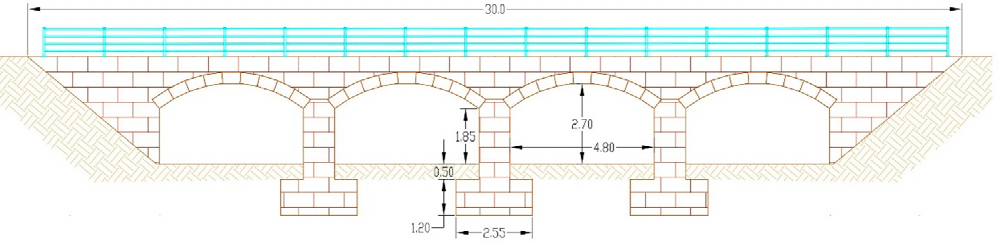
Figure 5. Masonry arch bridge under study (dimensions in meters).